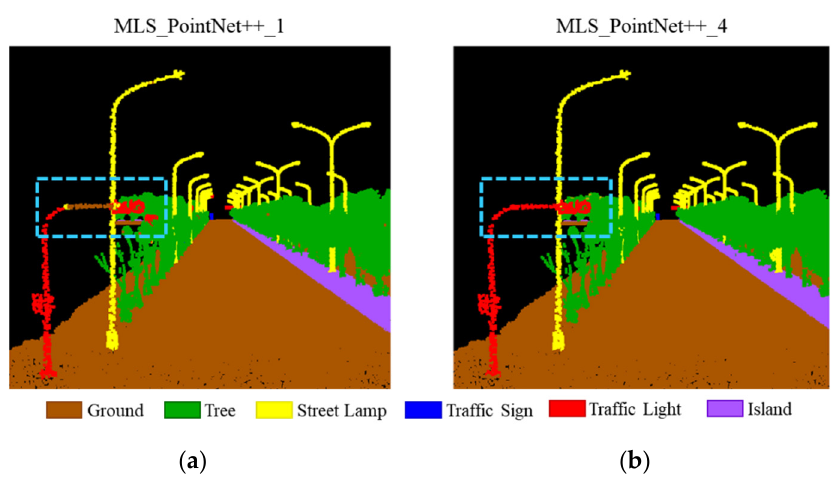
Figure 16. Comparison of classification results on MLS point clouds: ( a ) MLS_PointNet++_1; ( b ) MLS_PointNet++_5. The height feature is helpful to rectify the misclassification of the long, thin pole of the traffic light as the ground.